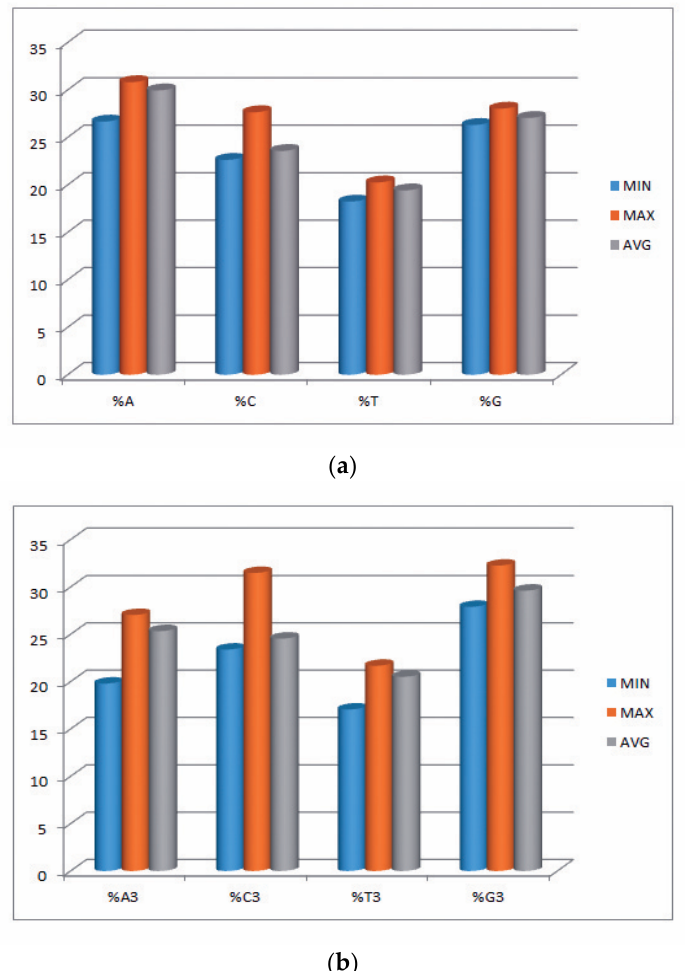
Figure 1. ( a ) Minimum, maximum, and average values of nucleobases A, C, T, and G of the EPB41L3 gene. ( b ) Minimum, maximum, and average of nucleobases at third position %A3, %C3, %T3, and %G3 of the EPB41L3 gene.